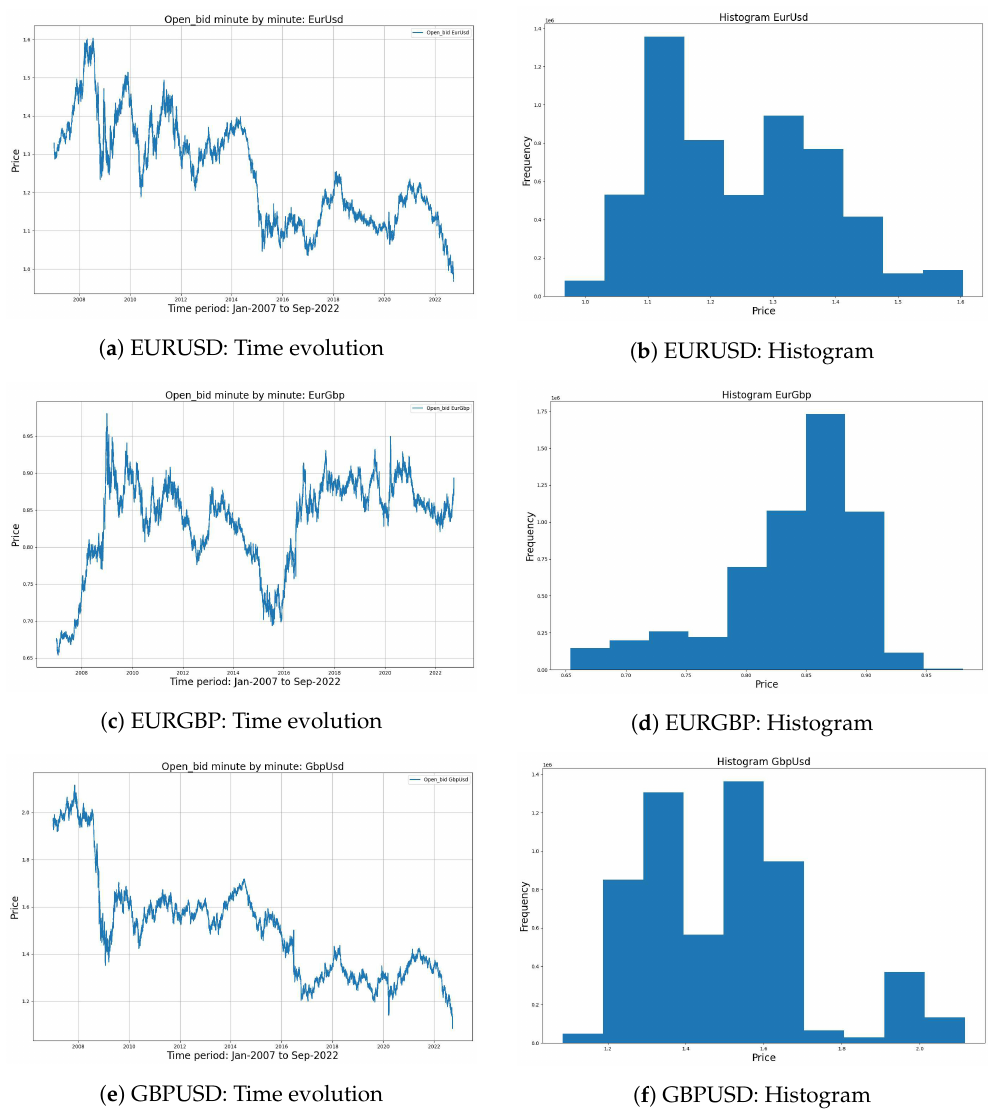
Figure 4. Plot showing the time evolution of the three currencies pairs. On the right, we also included a histogram for each of them considering the time period analysed between June 2007 and September